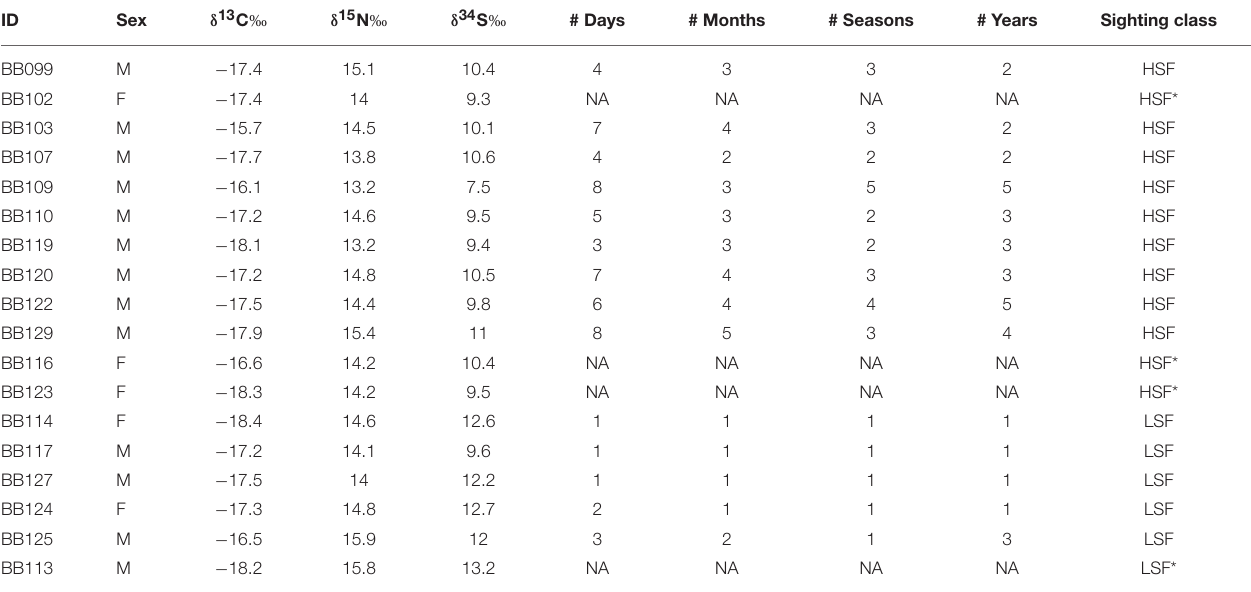
TABLE 2 | Dolphins sampled in St. George